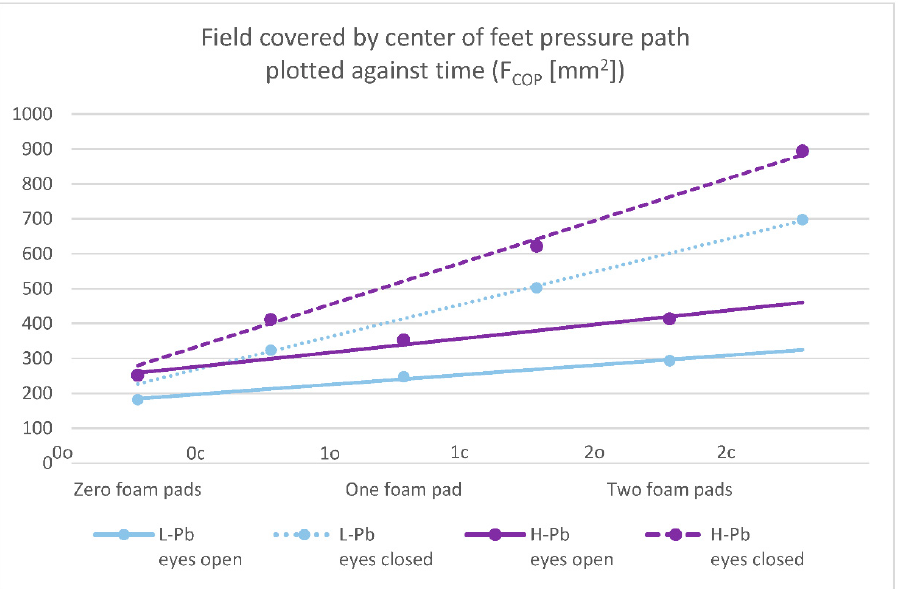
Figure 1. Posturography test results: a field covered by the center of feet pressure path plotted against time—F COP (mm 2 ). L-Pb—low-PbB-level subgroup, H-Pb—high-PbB-level subgroup. Posturographic parameters are described in Table 7. A trend line has been marked. Calculations based on the values in Table 3. The level of statistical significance was set at p < 0.05.